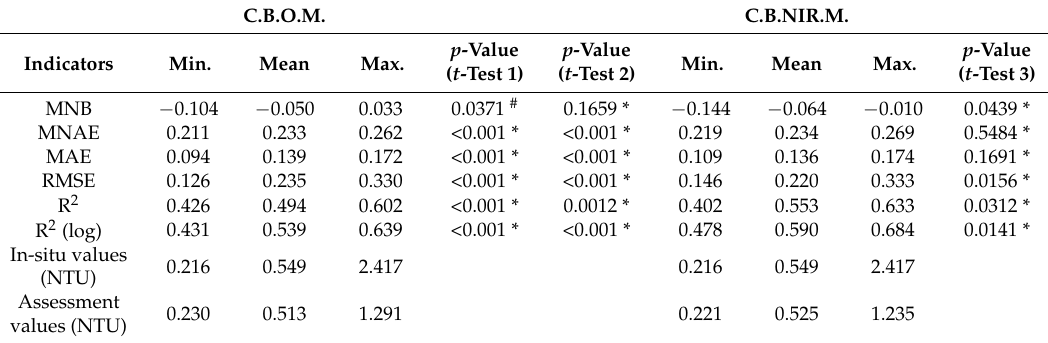
Table 2. Minimum, mean and maximum values for the series of indicators computed on each test sample with C.B.O.M. and C.B.NIR.M. (see section 3.3). The t ‐ tests p ‐ values indicate the statistical significance of improvements between models. The t ‐ test 1: O.M. vs. B.O.M.; the t ‐ test 2: B.O.M. vs. C.B.O.M.; t ‐ test 3: C.B.O.M. vs.